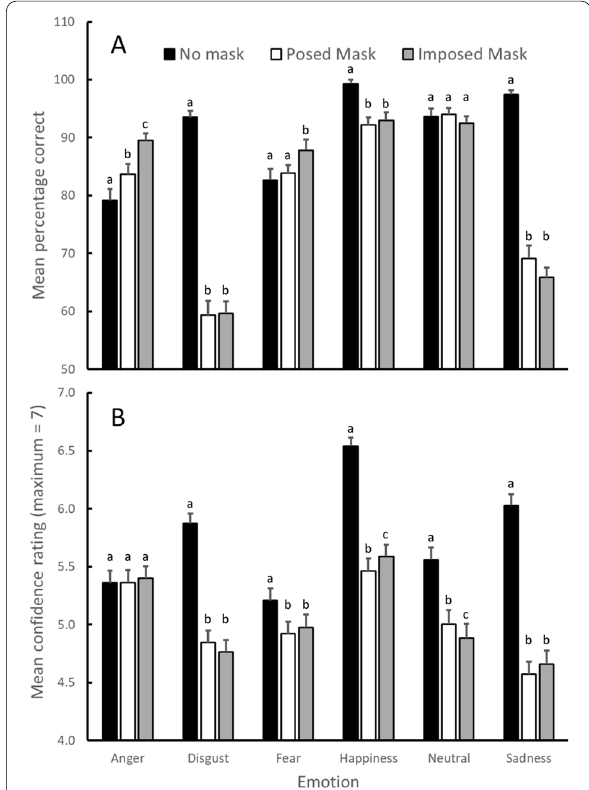
Fig. 2 Accuracy and confidence results. a Mean percentage correct (with SEM) identification of emotional state, and b mean confidence rating (with SEM), as a function of emotion and mask condition. Note: superscript letters indicate the presence/absence of significant differences between mask conditions for each emotion: conditions with different letters are significantly different from each other ( p < 0.05), conditions with the same letter are not significantly different ( p >